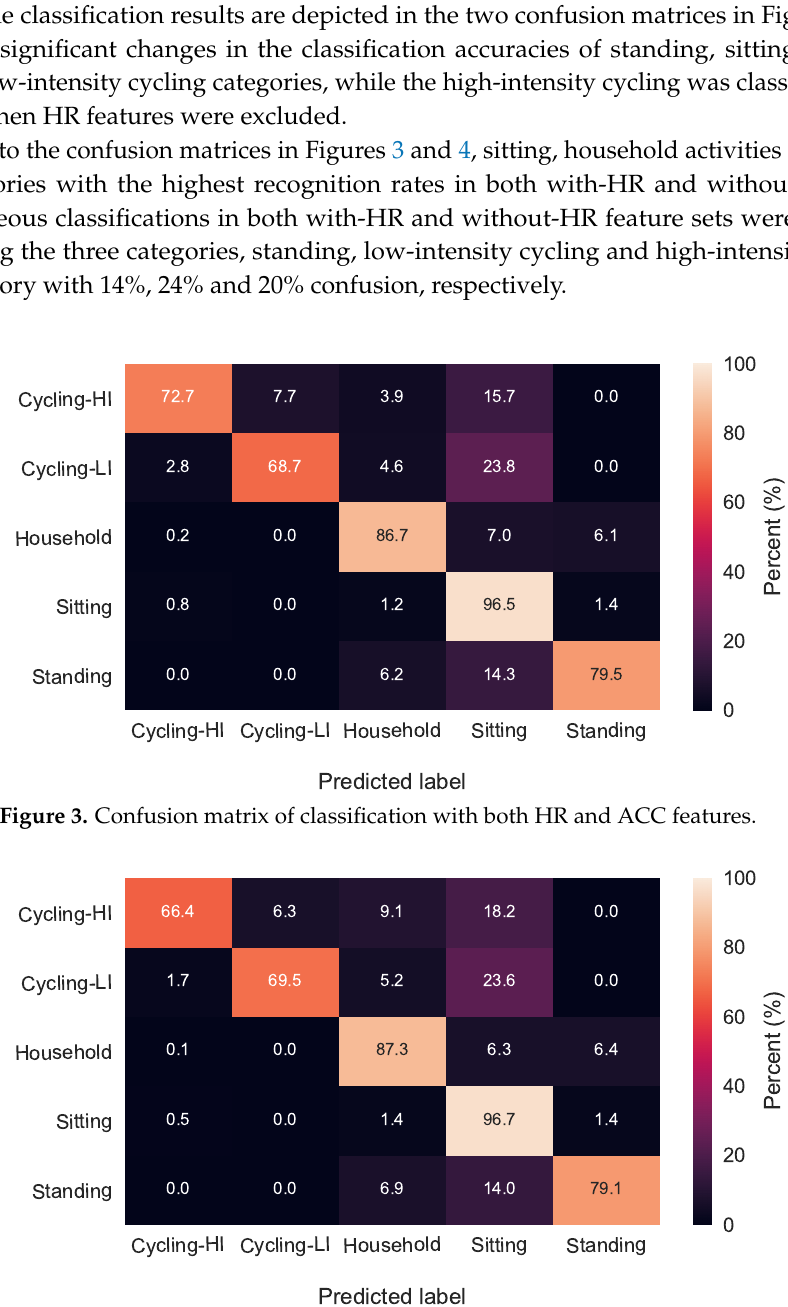
Figure 4. Confusion matrix of classification with only ACC